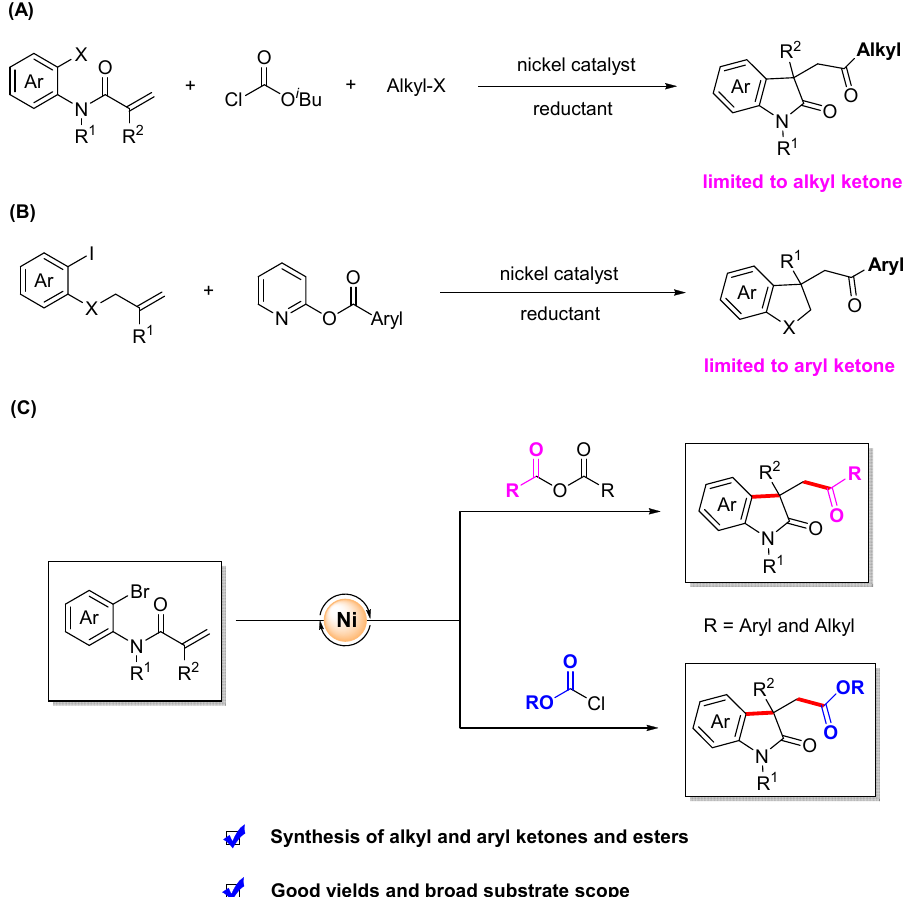
Scheme 1. The state of the art of Ni-catalyzed reductive aryl-acylation of alkenes. ( A ) Ni-catalyzed reductive aryl-acylation of alkenes [48]. ( B ) Ni-catalyzed reductive aryl-acylation of alkenes [49]. ( C ) Ni-catalyzed reductive aryl-acylation and aryl-esterification of alkenes (This work).